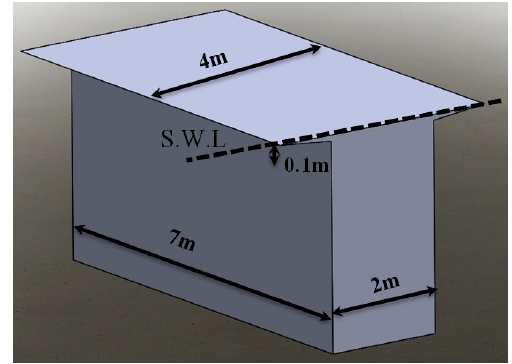
Figure 25. Description of the final optimized shape.